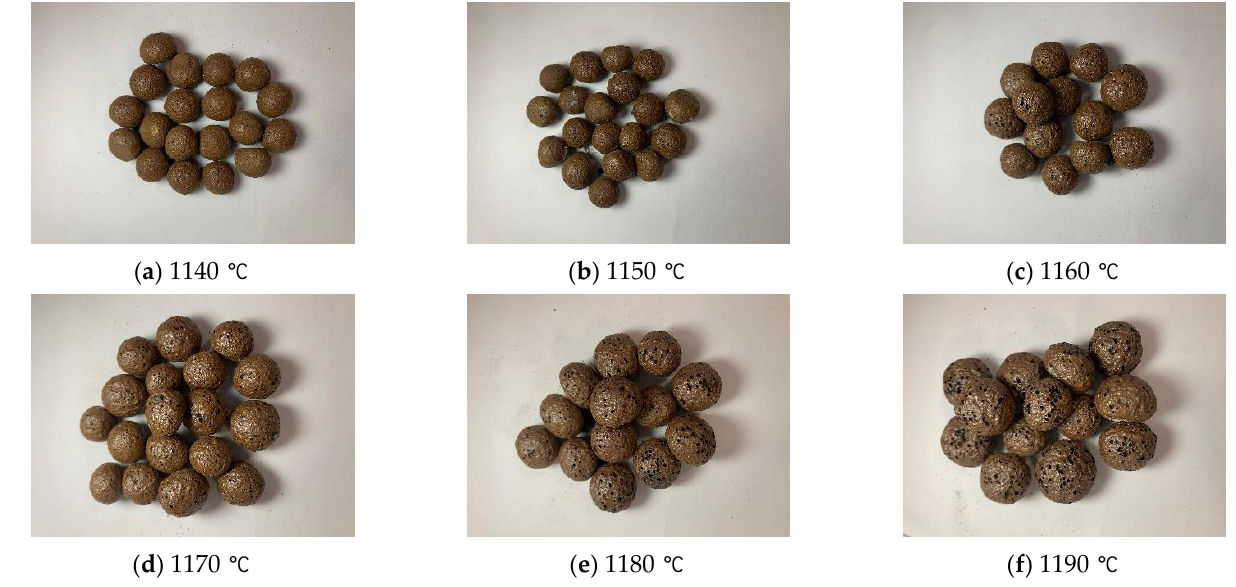
Figure 4. Appearance of ceramsites sintered at different sintering temperatures: ( a ) 1140 ◦ C, ( b ) 1150 ◦ C, ( c ) 1160 ◦ C, ( d ) 1170 ◦ C, ( e ) 1180 ◦ C, ( f ) 1190 ◦